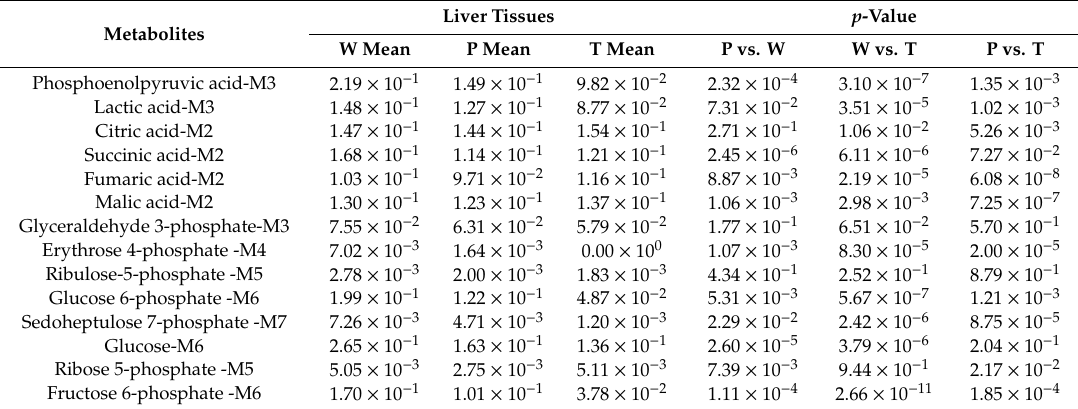
Table 3. DEMs in paired comparisons between W, P, and T by the targeted metabolomics analysis incorporating [U- 13 C]